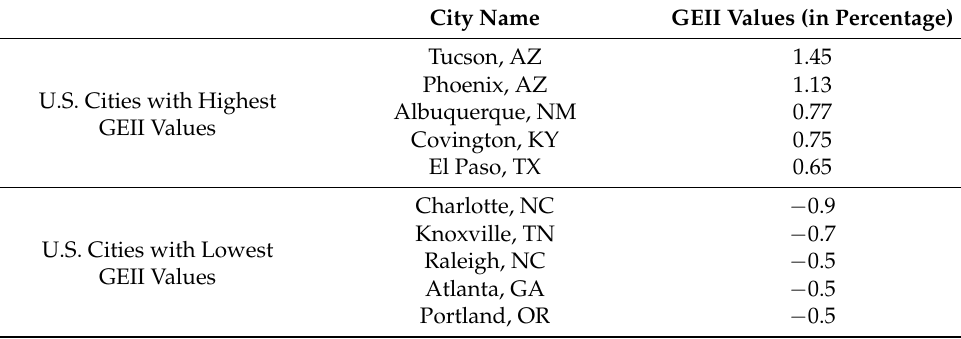
Table 8. Top and bottom five U.S. cities with the highest and lowest GEII values. City Name GEII Values (in Percentage)